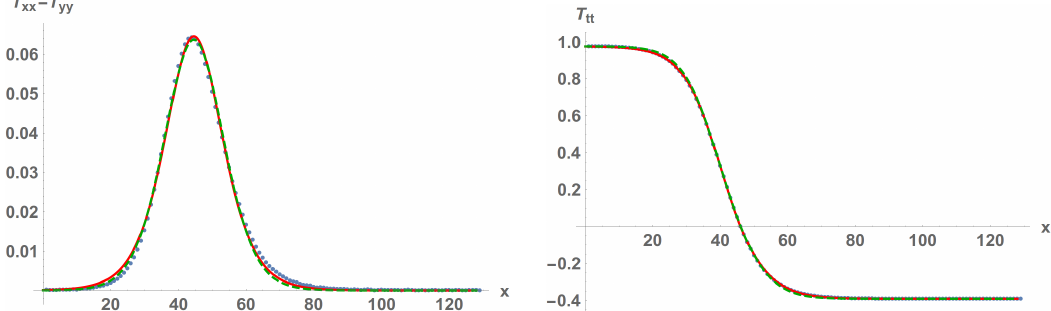
Figure 11 . Reproducing the numerical domain wall between two deconfined phases for the noncon- formal bottom-up holographic gravity+scalar theory from [5]. On the left: surface tension density T xx − T yy fitted using option A (red) and option B (dashed green). On the right: energy density T tt using the same B (Γ) for both options. The numerical data marked by blue dots are taken from simulations performed in